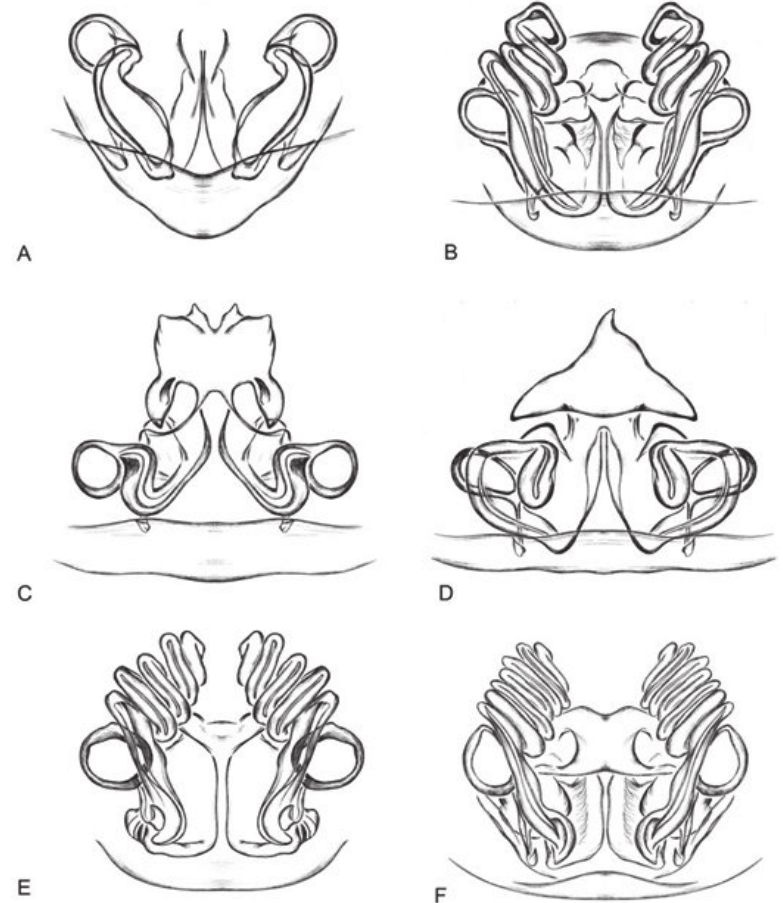
Figure 21. Internal female genitalia, dorsal view. A , Oxyopes macilentus L. Koch, 1878 ( ZMH- A0000012); B , Oxyopes molarius L. Koch, 1878 ( ZMH- A0000013); C , Oxyopes punctatus L. Koch, 1878 ( ZMH- A0000016); D , Oxyopes quadrifasciatus L. Koch, 1878 ( ZMH- A0000018 ) ; E , Oxyopes rubicundus L. Koch, 1878 ( ZMH- A0000019 ) ; F , Oxyopes variabilis L. Koch, 1878 (